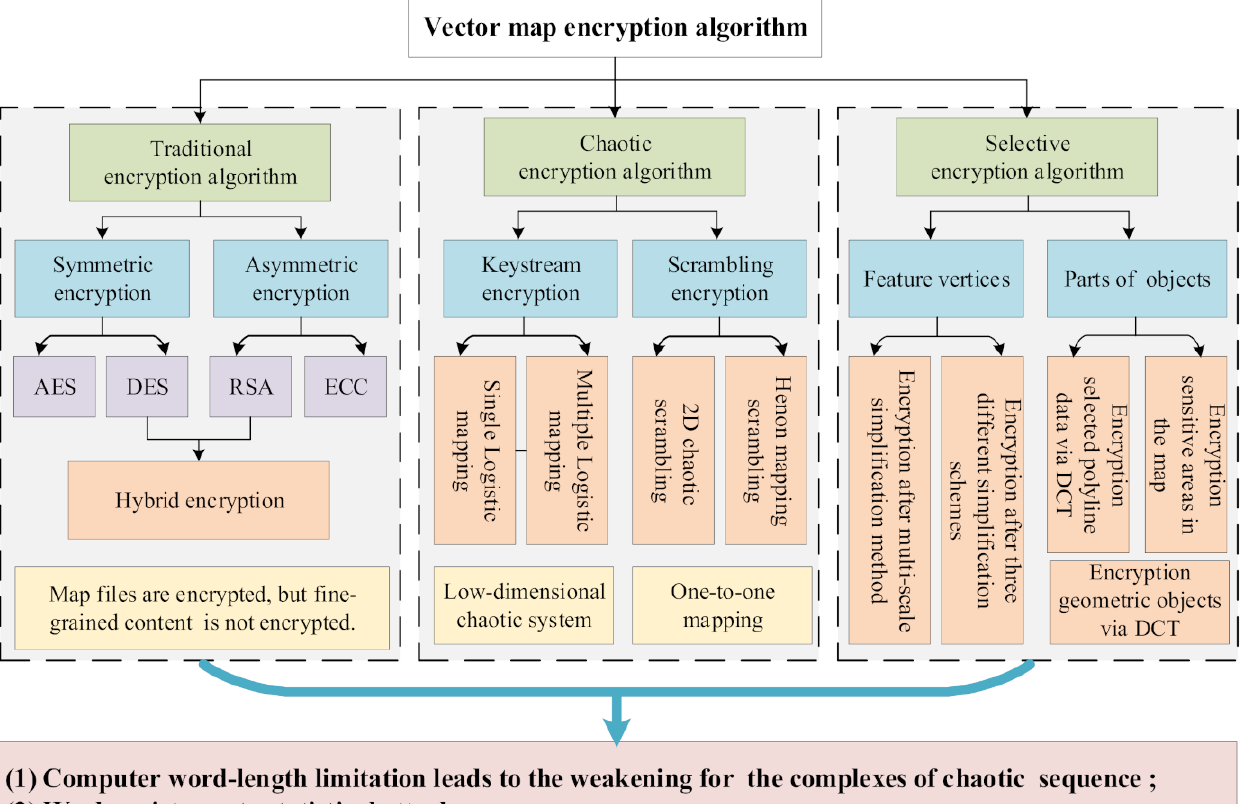
Figure 1. Categories of the vector map encryption